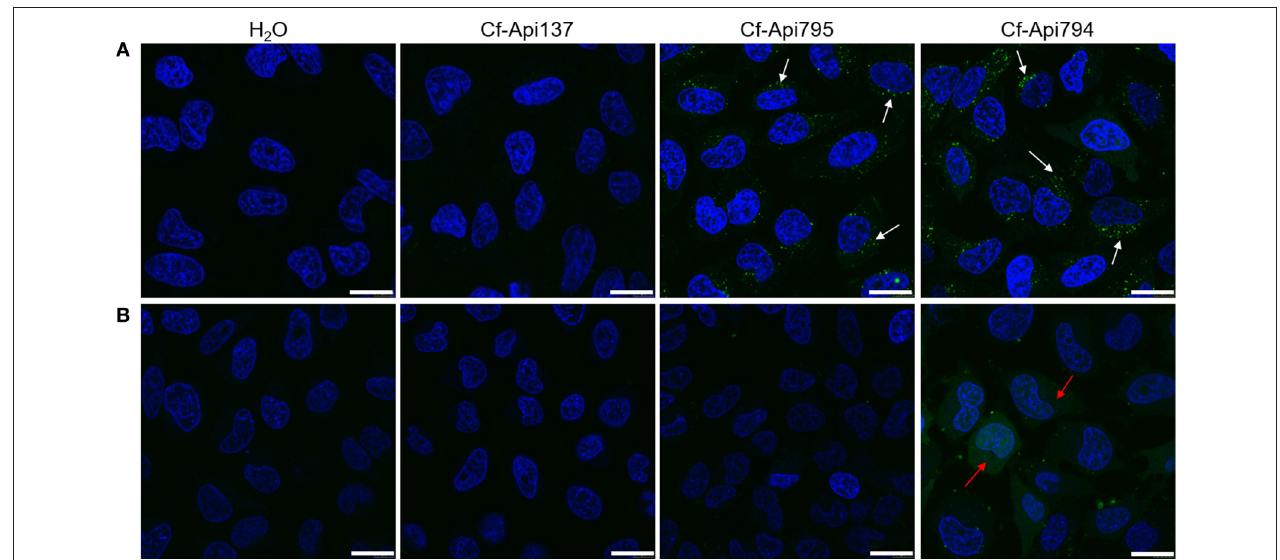
FIGURE 6 | Confocal microscopy images of HeLa cells incubated with Cf-labeled apidaecin peptides. Cells were treated without (A) or with dynasore (0.2 mmol/L; B ) for 45 min prior to peptide treatment (40 µ mol/L, 30 min). The cells’ nuclei were visualized with Hoechst 33324 (blue). Arrows indicate examples of areas with endosomes (white) and stained cytosol (red). Bars refer to 20 µ